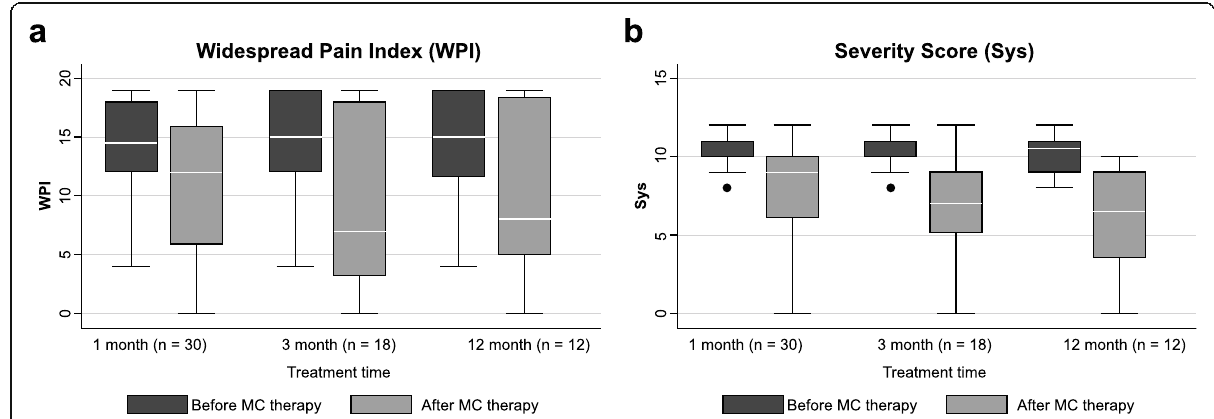
Fig. 6 Widespread Pain Index and Severity Score at 1, 3, and 12 months. Boxplots of a WPI and b SyS before and during MC therapy at 1, 3, and 12 months. Statistically significant improvements in WPI were registered for comparisons at 1 and 3 months, but not at 12 months ( P < 0.01). Statistically significant improvements of SyS were registered for comparisons at 1, 3, and 12 months ( P < 0.01). The boxes contain the middle 50% of the values; the thick white lines indicate the median; the whiskers connected by dashed lines to the boxes mark the minimum and maximum values except when there are outliners, which are specifically indicated by circles. WPI widespread pain index, SyS severity score, MC medical cannabis